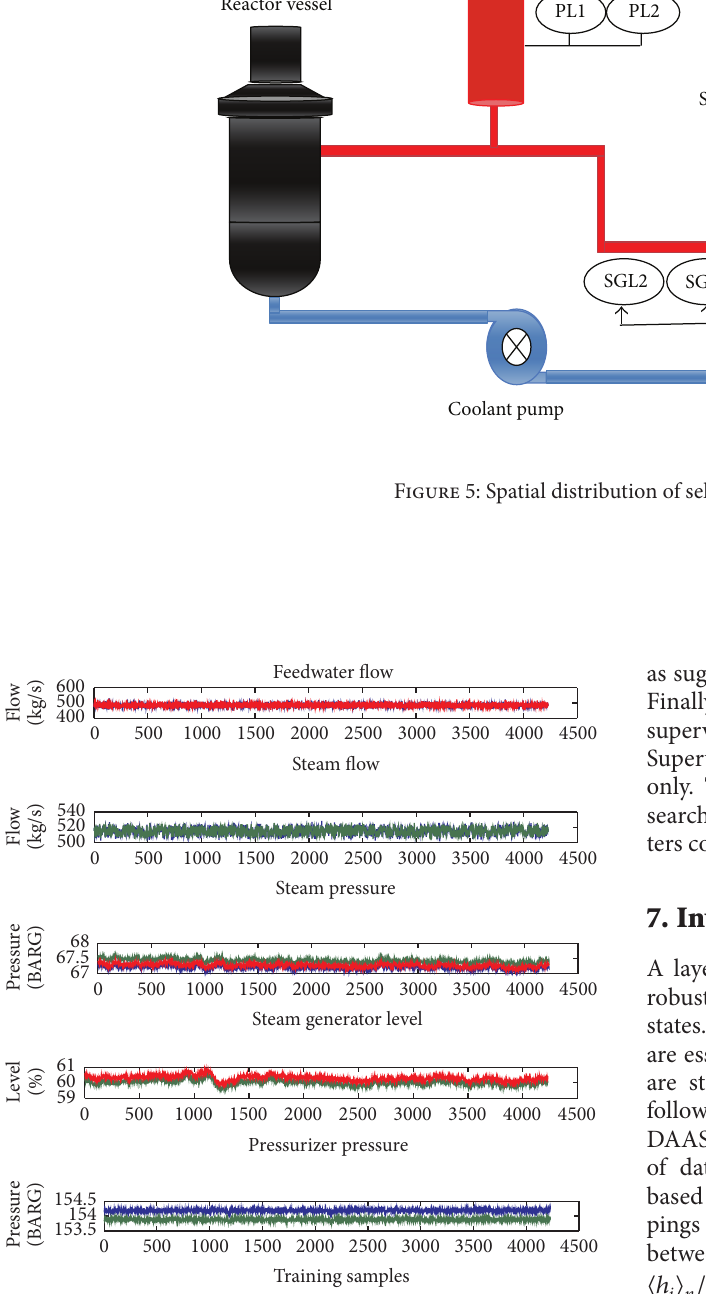
Figure 6: Plot of NPP sensors listed in Table